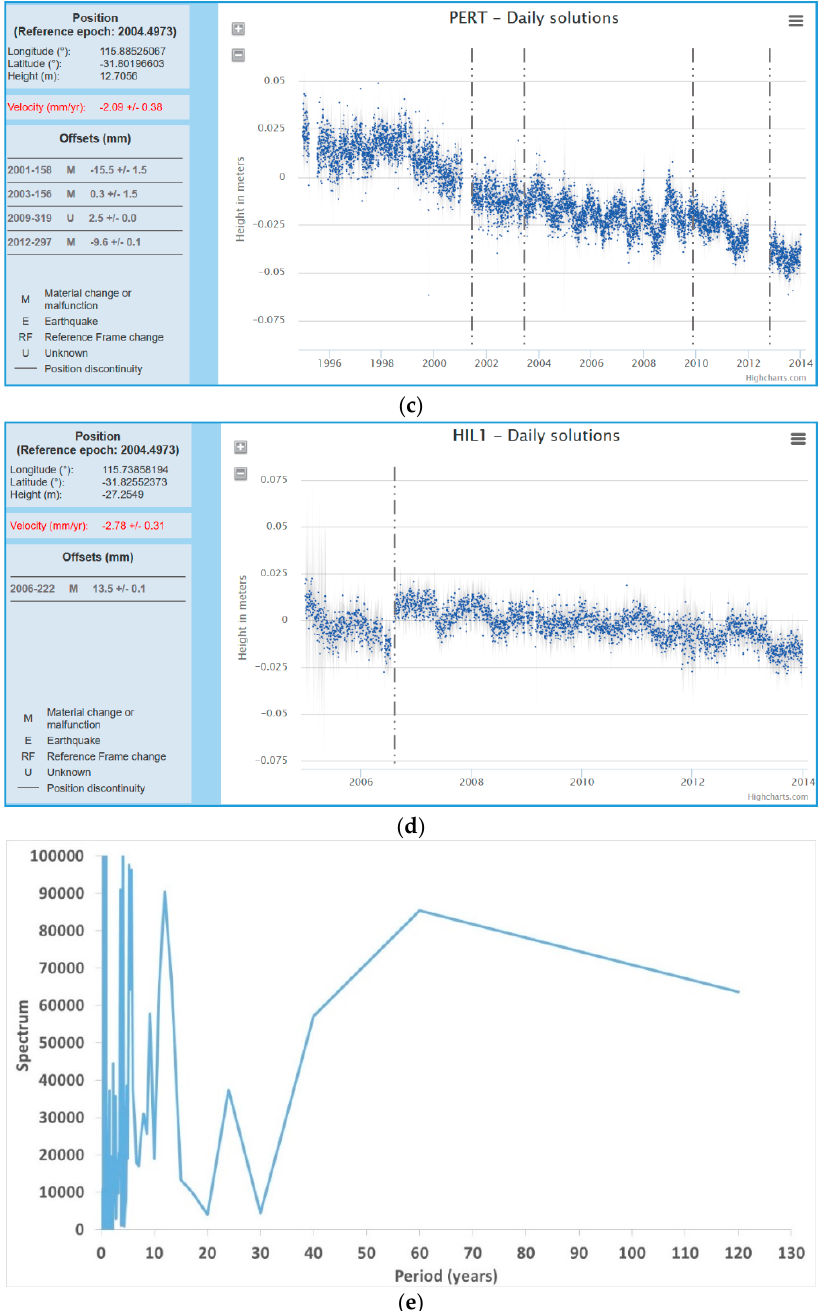
Figure 10. Fremantle. ( a ) and ( b ) linear and parabolic fittings of the PSMSL RLR data, as it is or with gaps filled. ( c ) and ( d ) subsidence rates of nearby GPS domes. Images reproduced and modified from SONEL, www.sonel.org. ( e ) Periodogram of the PSMSL RLR data with gaps filled about the parabolic trend.